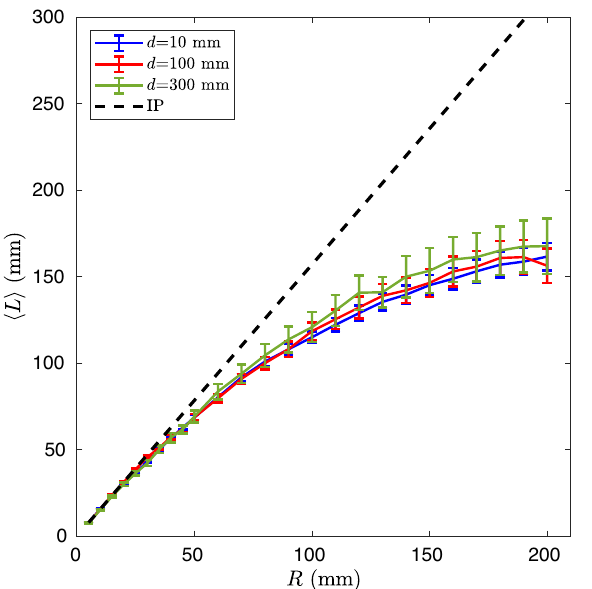
Figure 2. Average path length of the animals inside the inner circle of radius R . In the legend the values of the distance d from the external source circle. The mean free path ℓ MFP is about 50